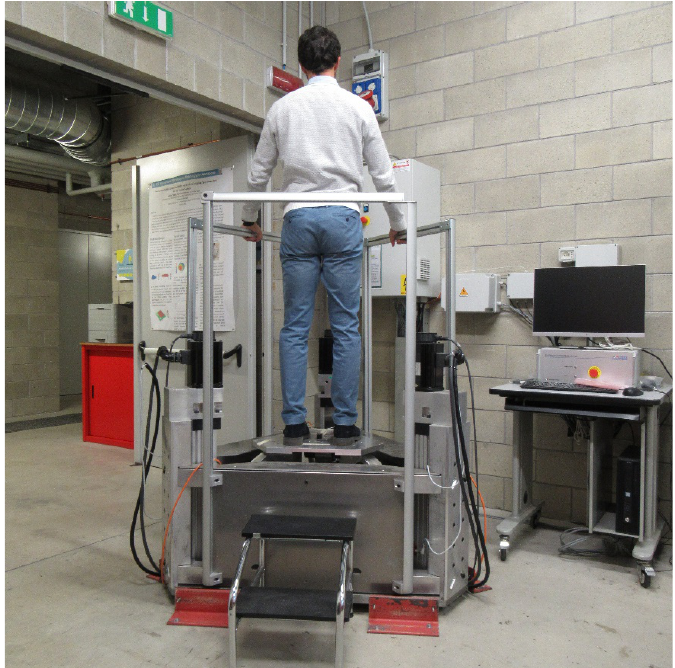
Figure 4. Person standing on the moving platform of the shaker.